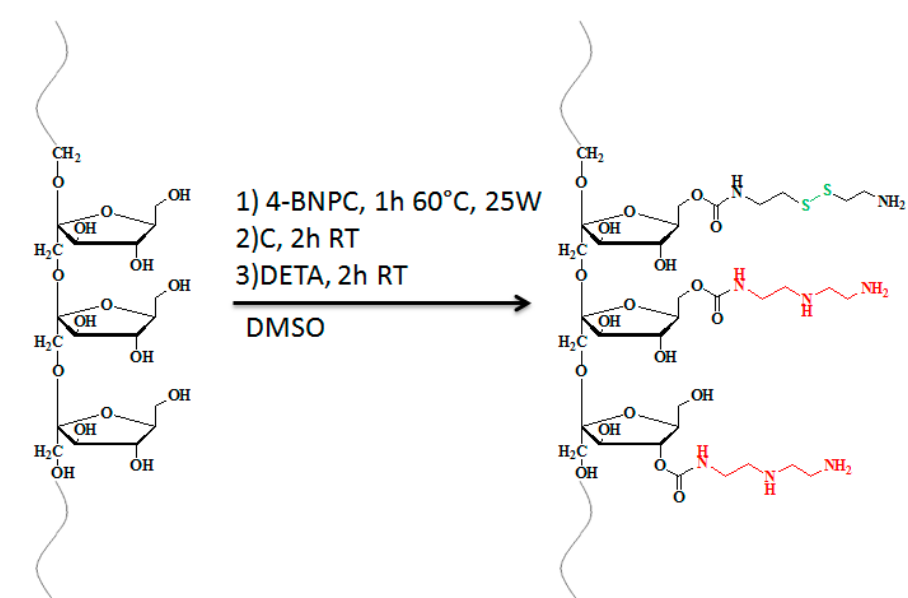
Scheme 1. Schematic representation of the synthesis of INU-C-DETA copolymer.